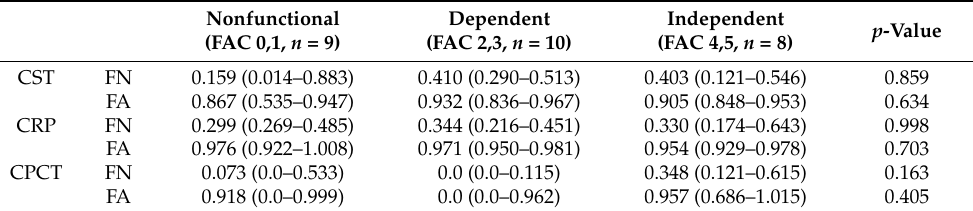
Table 4. FN and FA values of CST, CRP, CPCT by group according to the independence of ambulation